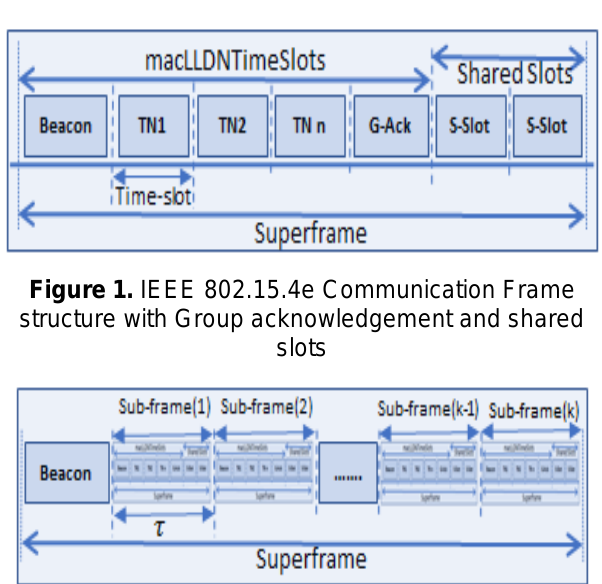
Figure 2. Superframe structure for the proposed scheduling